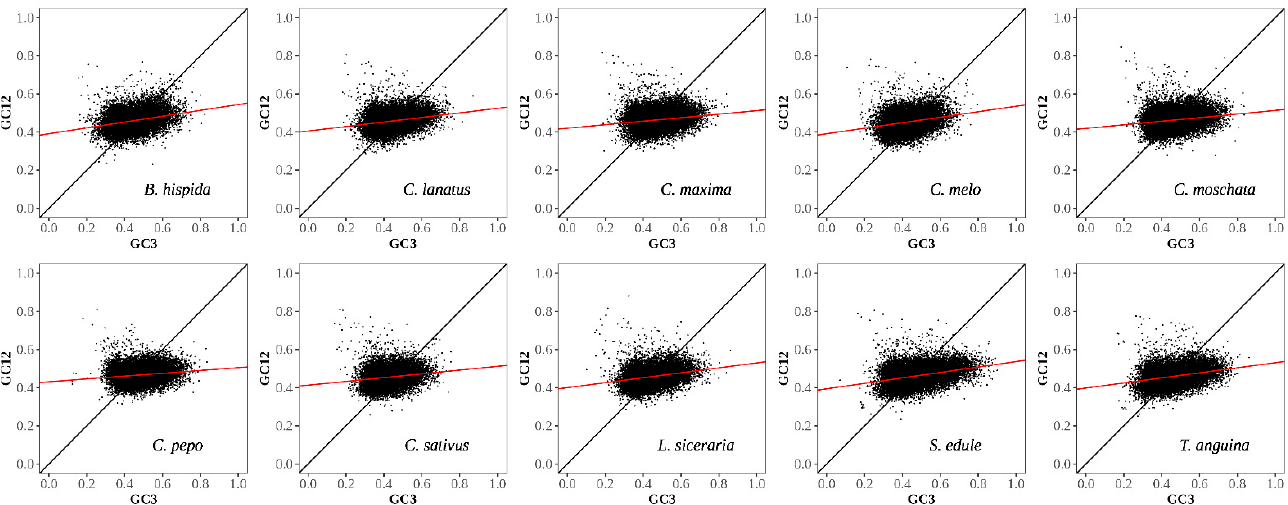
Figure 5. Neutrality plot analysis of genes in ten species of Cucurbitaceae. The vertical axis represents the GC content in the first two bases of the codon, and the horizontal axis represents the GC content in the third base. The points on the diagonal represent that the content of GC3 is equal to that of Gc12, indicating that codon usage bias is mainly affected by mutation. Otherwise, it was affected by natural selection. The red line represents the linear regression line. Here, the regression equation and the correlation coefficients of GC12 and GC3 of each graph are as follows: Bhi: y = 0.153x + 0.391, r =